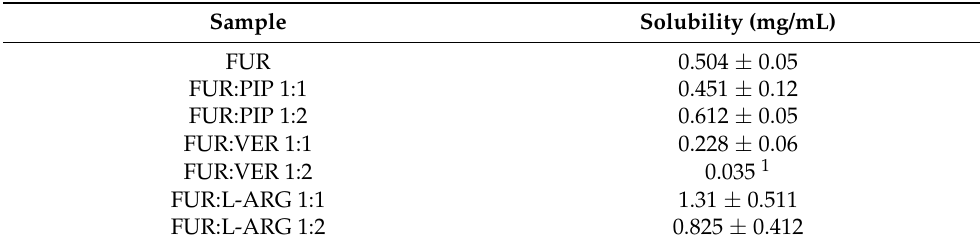
Table 2. Equilibrium solubility of FUR at pH 5.2 ( n = 3).